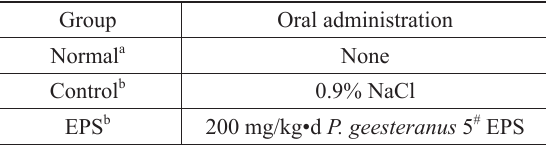
a Group of 8 normal mice. b Diabetic mice induced by streptozotocin (50mg/kg body weight) for 8 mice. The mice were administrated orally with either saline (control) or EPS produced from the submerged mycelial culture of P. geesteranus 5 # at 200 mg/kg body weight daily for 3